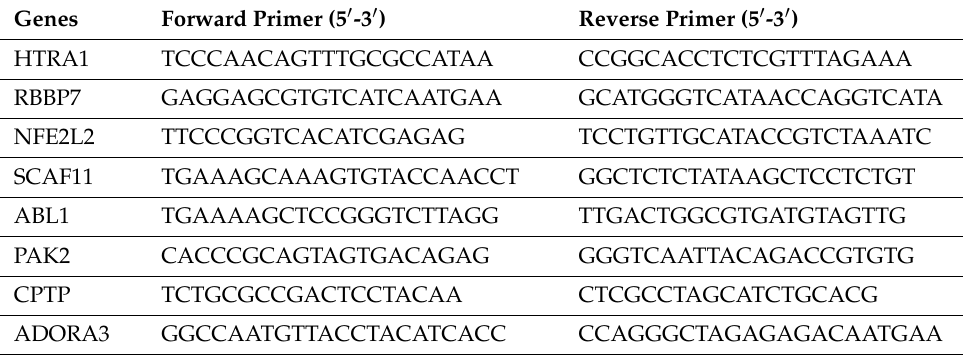
Table 1. Primer sequences of 8 pyroptosis related genes. Genes Forward Primer (5 (cid:48) -3 (cid:48)